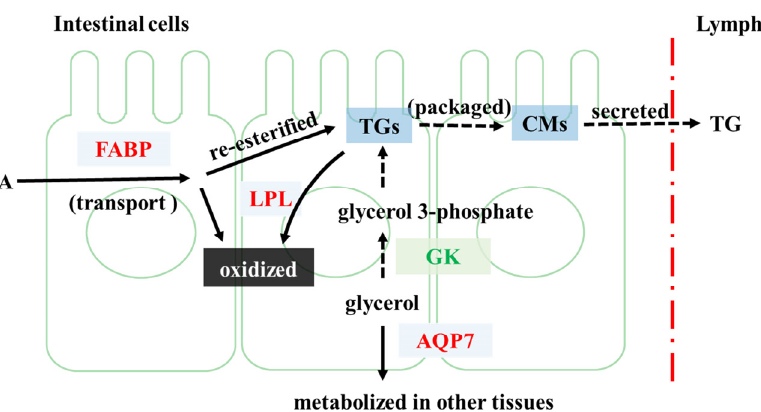
Figure 6. Potential regulatory mechanism by which FP may alter genes related to lipid metabolism in CETs. FP intervention upregulates FABP and LPL, promoting the transport of FA in CETs and re-oxidation and decomposition of the re-esterified TGs, which might help to reduce the secretion of TG to Lymph. GK is downregulated, reducing the conversion of glycerol to TG synthesis substrate. AQP7 is upregulated, promoting the transfer and metabolism of glycerol to other tissues. Note that proteins in red represent upregulation in group FPD compared with group HFD, while those in green indicate downregulation.